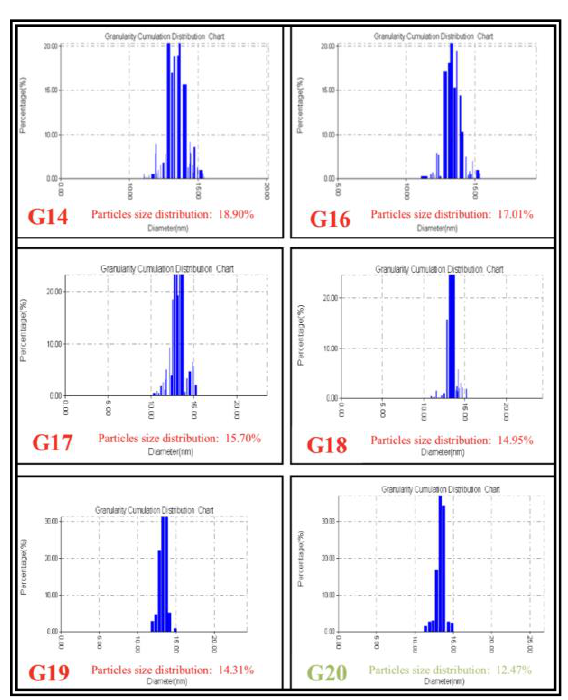
Figure 12. AFM size distribution of